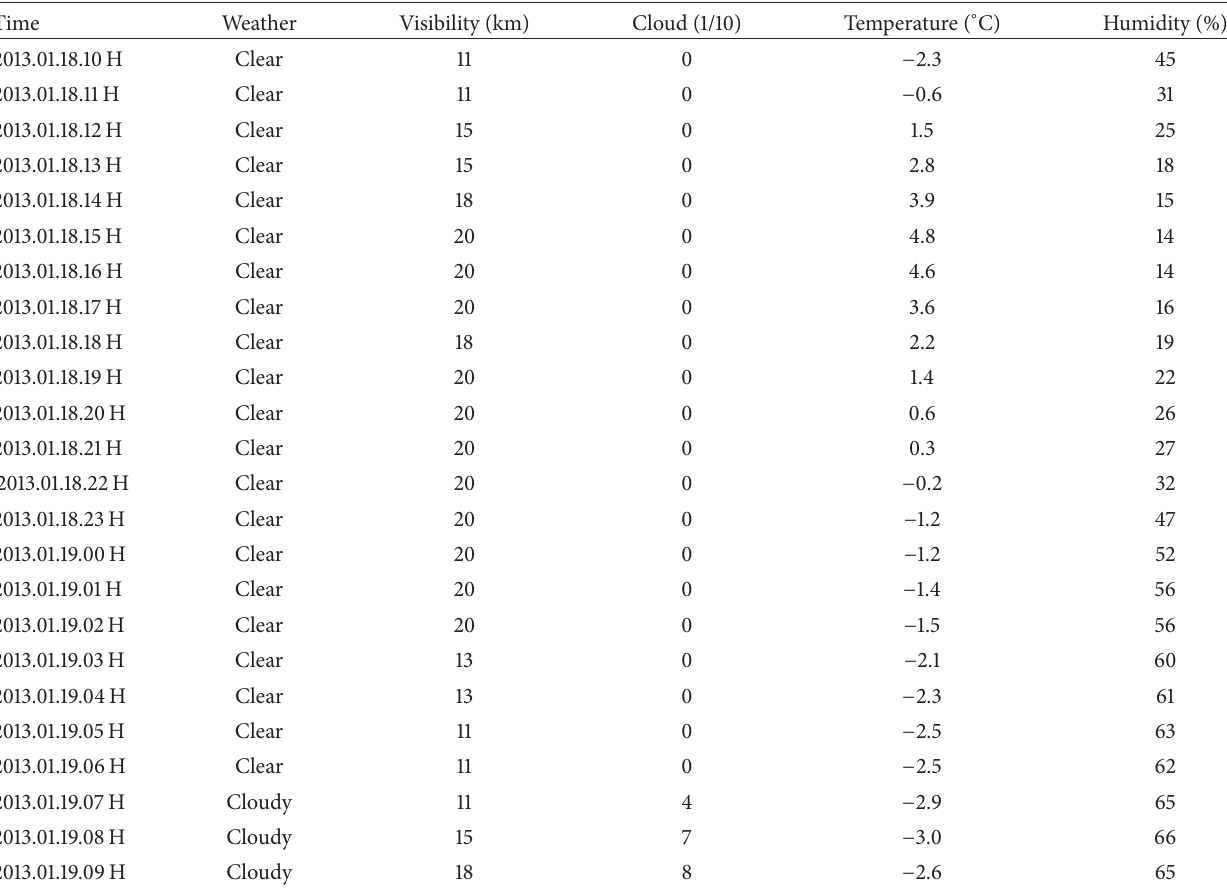
Table 2: Measured meteorological data of the recording place